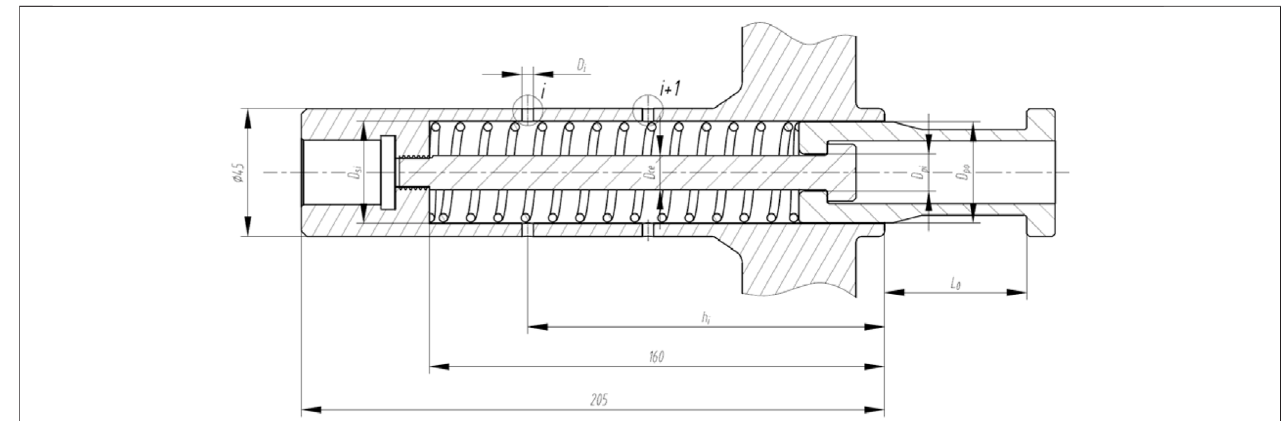
FIGURE 3 | Simpli fi ed schematic and key parameters of spider hydraulic buffer.